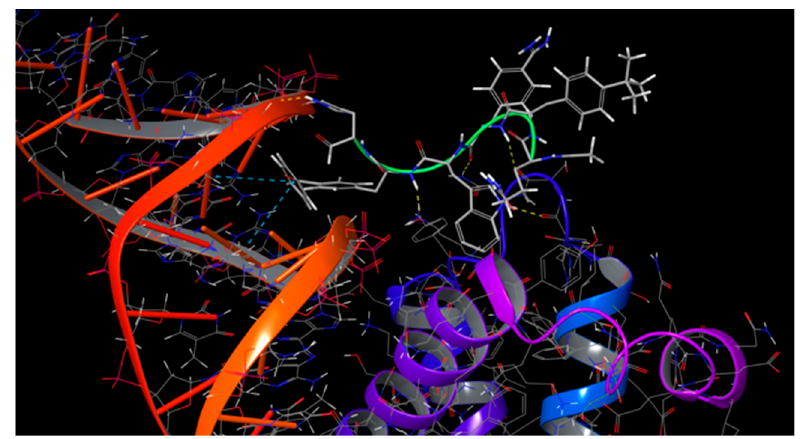
Figure 6. Binding mode of the first combinatorial peptide to PBX1 and DNA.